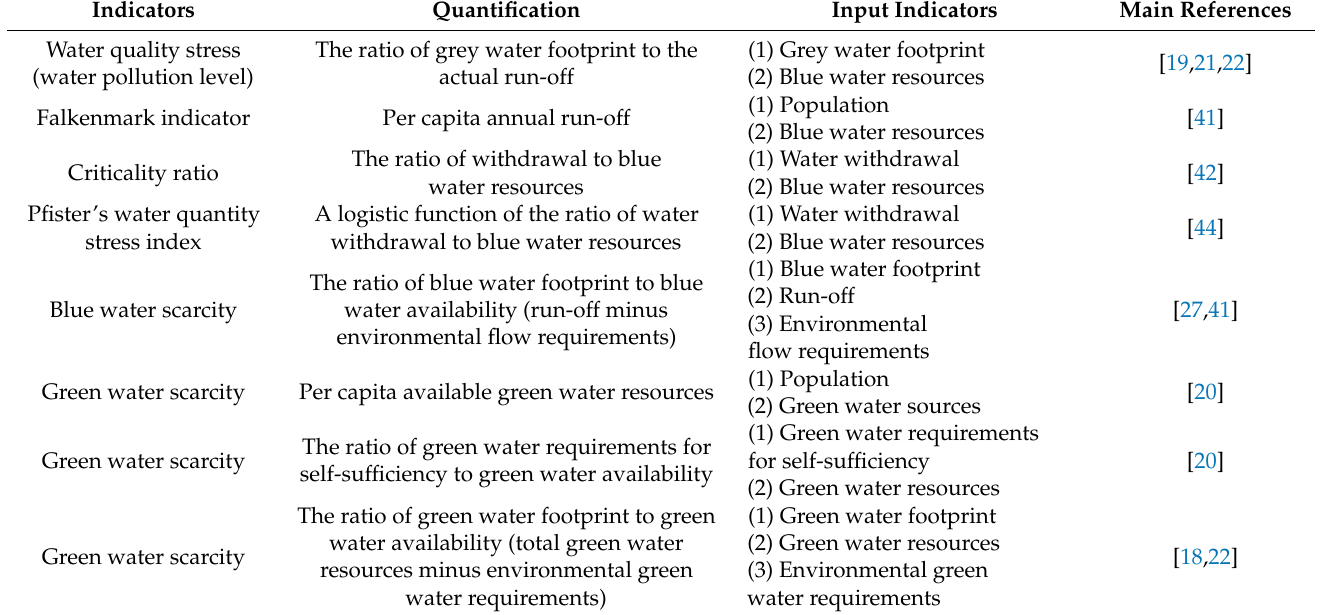
Table 2. Summary of indicators to measure physical water